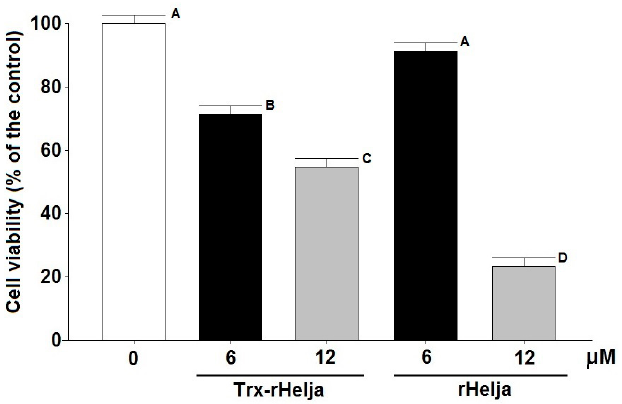
Figure 4. Cell viability of human SH-SY5Y neuroblastoma cells treated with Trx-rHelja or rHelja. The cells at density of 5 × 10 4 cell/well were grown for 24 h before the incubation with 6 and 12 μ M Trx-rHelja or rHelja. After an additional 24 h, MTT reagent was added to the wells. Dimethyl sulfoxide was used to dissolve the formazan complex and the absorbance was measured at 570 nm. The cellular viability was expressed as a percentage of the value obtained in the absence of treatment. Each experiment was tested in triplicates and they were repeated at least three times. Standard deviation, one-way ANOVA and Tukey test analysis ( p ≤ 0.05) were performed using InfoStat software (2014, Agricultural College of the National University of Córdoba, Córdoba, Argentine). Different capital letters indicate significant differences.